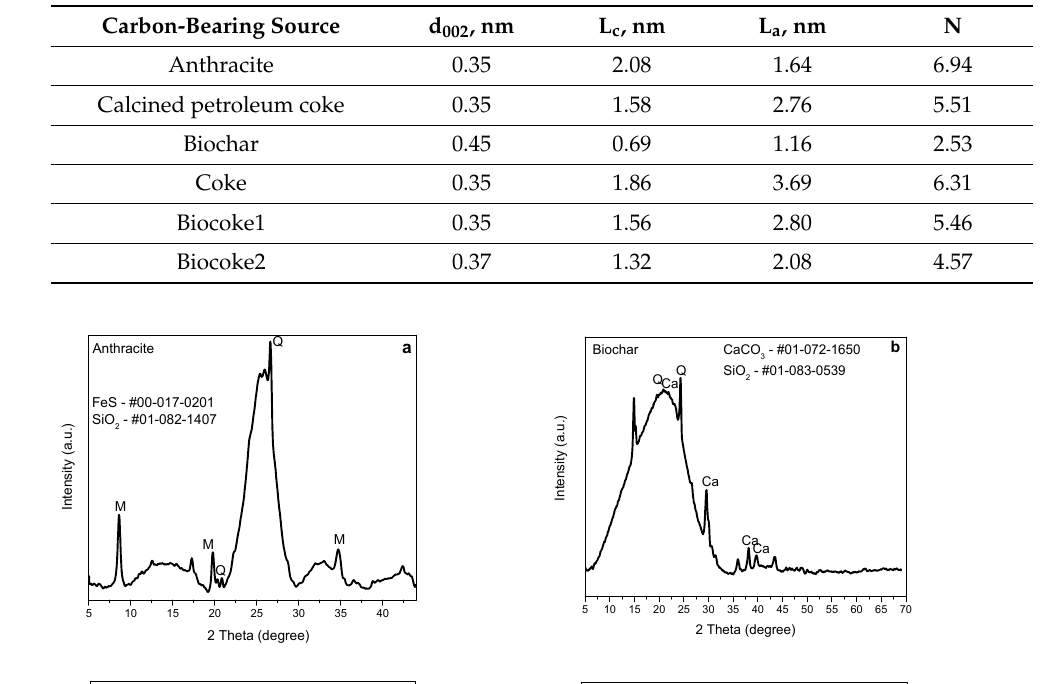
Table 6. The XRD parameters for the carbon-bearing sources.